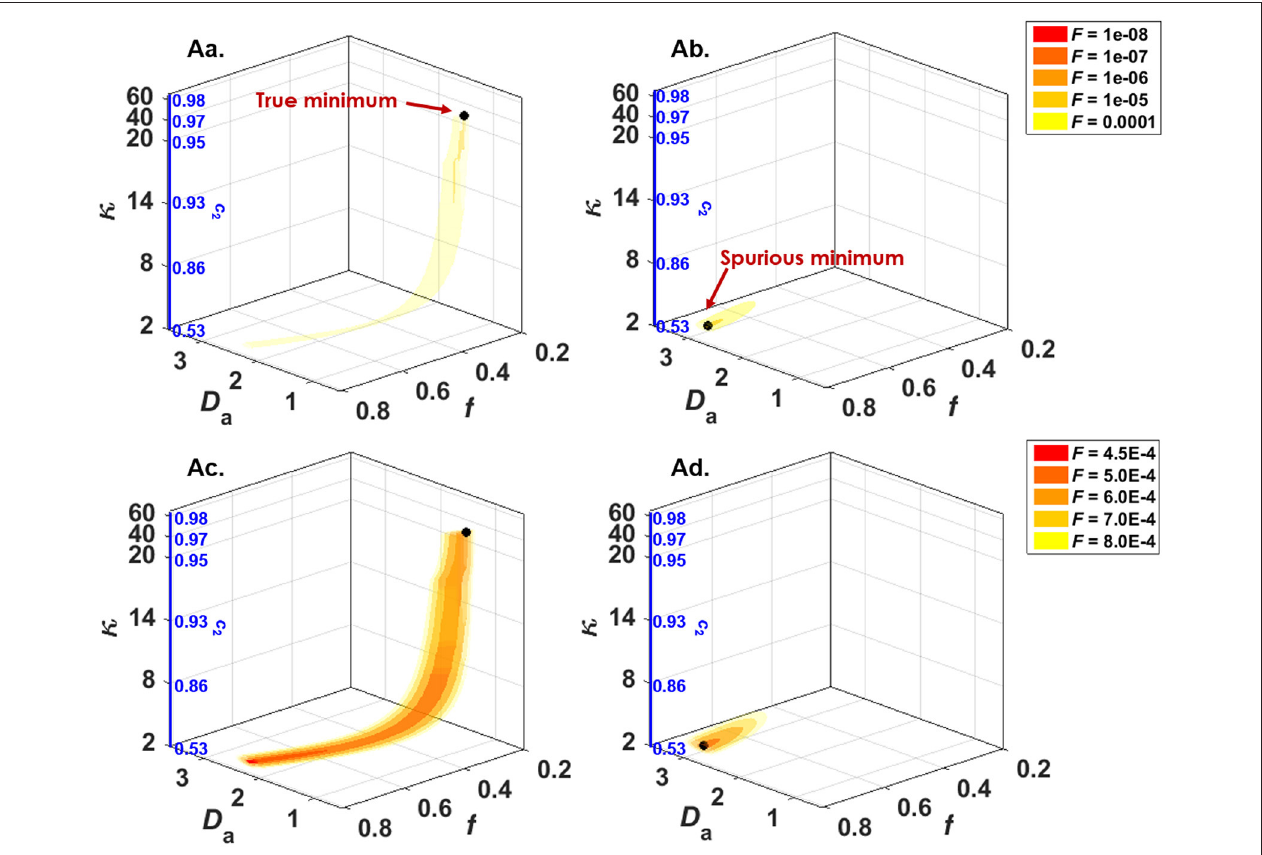
FIGURE 2 | NODDIDA optimization landscape reveals the existence, in the full 5-parameter space, of two disconnected minima, each surrounded by a pipe-like ensemble of low objective function values. Shown are 3D isosurfaces of the objective function F ( f , D a, , thus containing the true global minimum. (Ab) F calculated with ( D e, = ∞ minimization problem. (Ac) The same as (Aa) , but SNR black bullet. Noise can displace the effective minimum along the pipe very far from the true one (see Ac ). Figure taken from Jelescu et al. [49], with